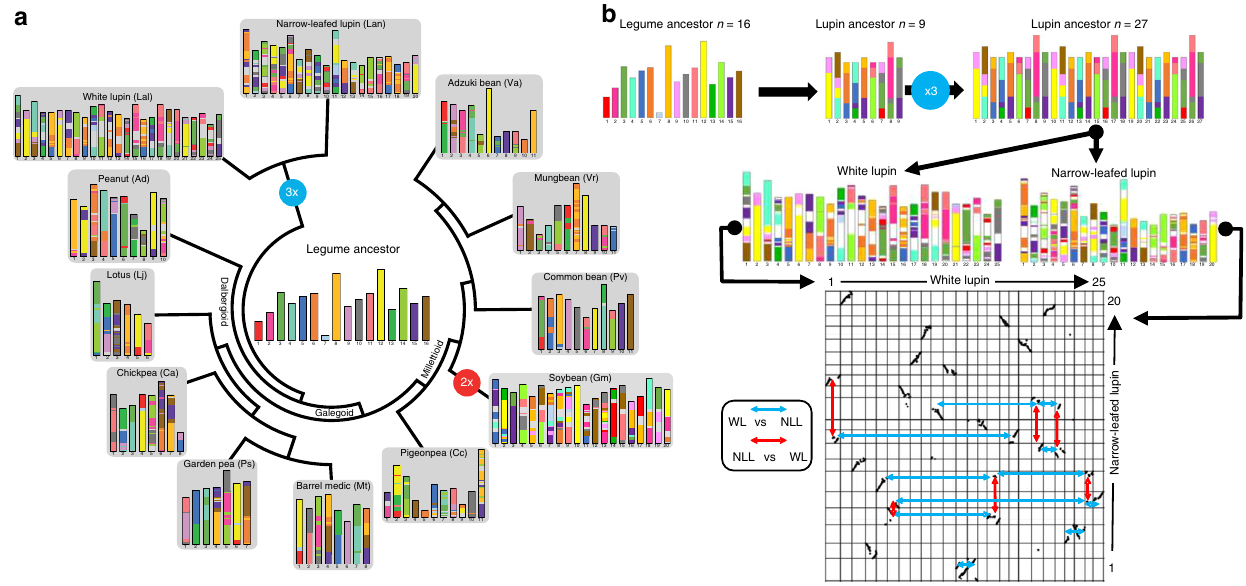
Fig. 3 White Lupin genome evolution. a Legumes evolutionary history. Evolutionary scenario of the modern legumes (white and narrow-leafed lupin, garden pea, peanut, Lotus, barrel medic, chickpea, pigeonpea, soybean, common bean, mungbean, and adzuki bean) from the reconstructed ancestral legume karyotype (ALK, center). The modern genomes are illustrated with different colors re fl ecting the origin from the ancestral chromosomes. Polyploidization events are shown with red (duplication) and blue (triplication) dots on the tree branches. b TOP- Evolution of white and narrow-leafed lupin genomes from ALK (with 16 CARs) and the lupin ancestral genomes (with 9 and 27 CARS excluding the small CAR #7 in ALK). BOTTOM- Synteny relationships between white (horizontal) and narrow-leafed (vertical) lupin illuminating 17 major chromosomal shuf fl ing events (red and blue arrows for respectively narrow-leafed lupin compared to white lupin and white lupin compared to narrow-leafed